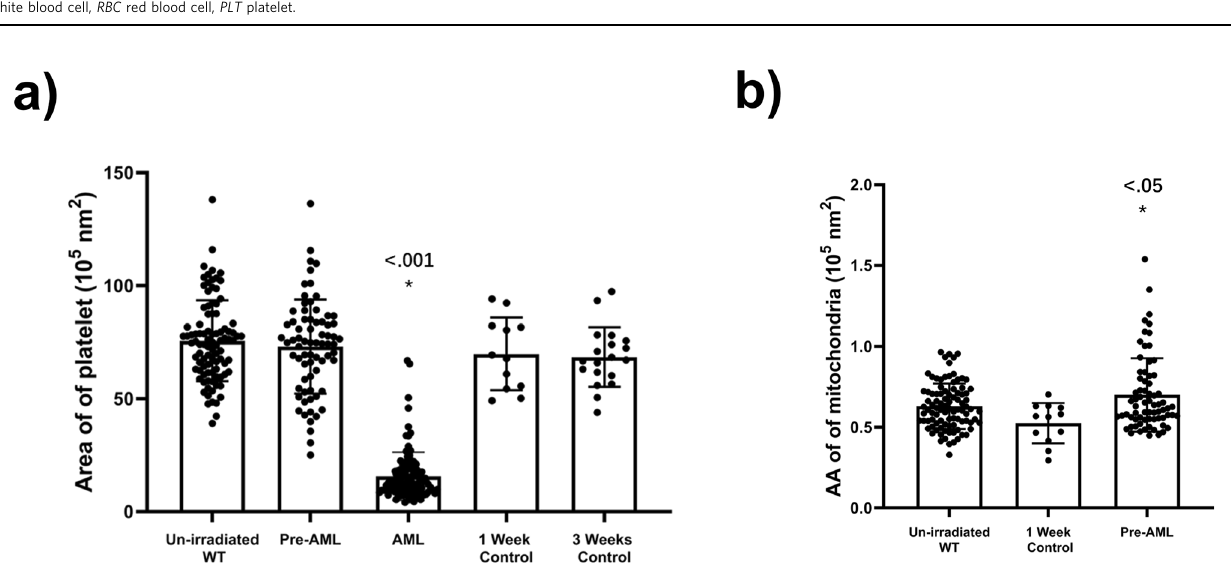
Fig. 2 Statistics of platelets from mice in different states. a There were no differences in the size of platelets from pre-AML, control mice and un- irradiated mice, while the size of platelet from AML mice was signi fi cantly decreased. b The average area (AA) of mitochondria in pre-AML platelets increased compared with un-irradiated and control groups ( P < 0.05). Data are presented as mean ± s.e.m. Student ’ s t test were used for statistical analyses. * P ≤